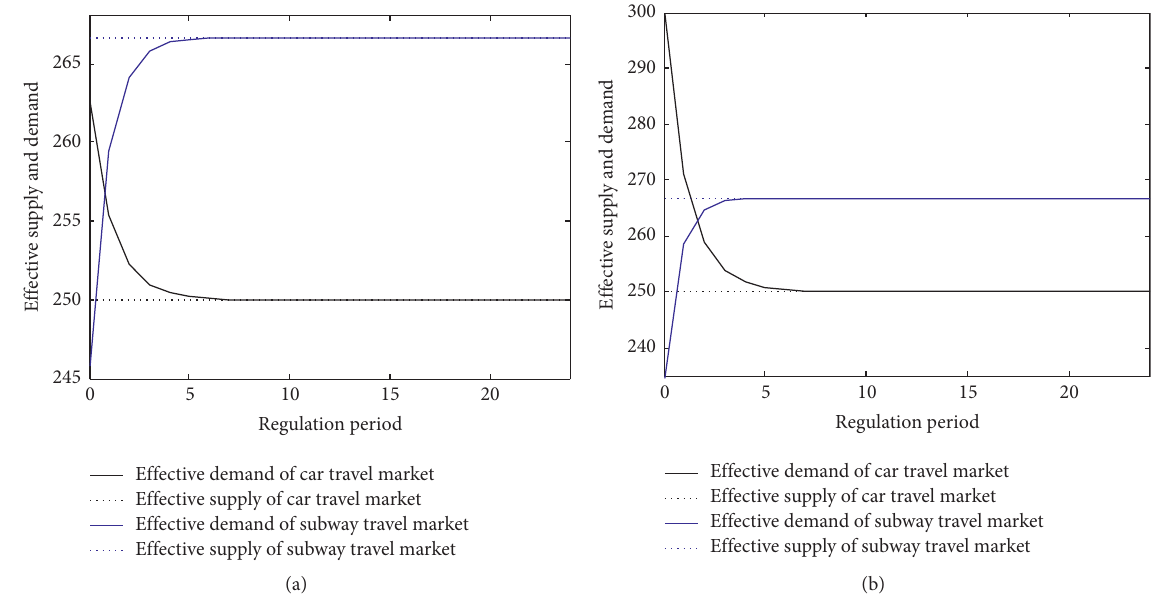
Figure 2: Regulation process of effective supply and demand in the multimodal travel market. (a) OD pair (1,2). (b) OD pair (1,3). Table 1: Optimal price regulation